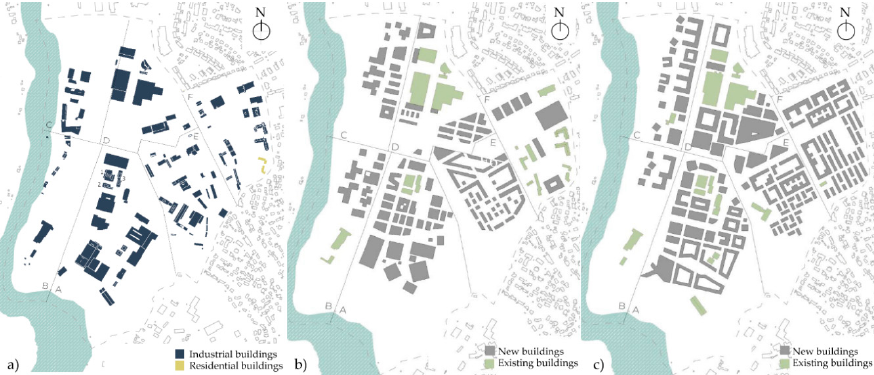
Figure 1. Overview of the Sluppen area.